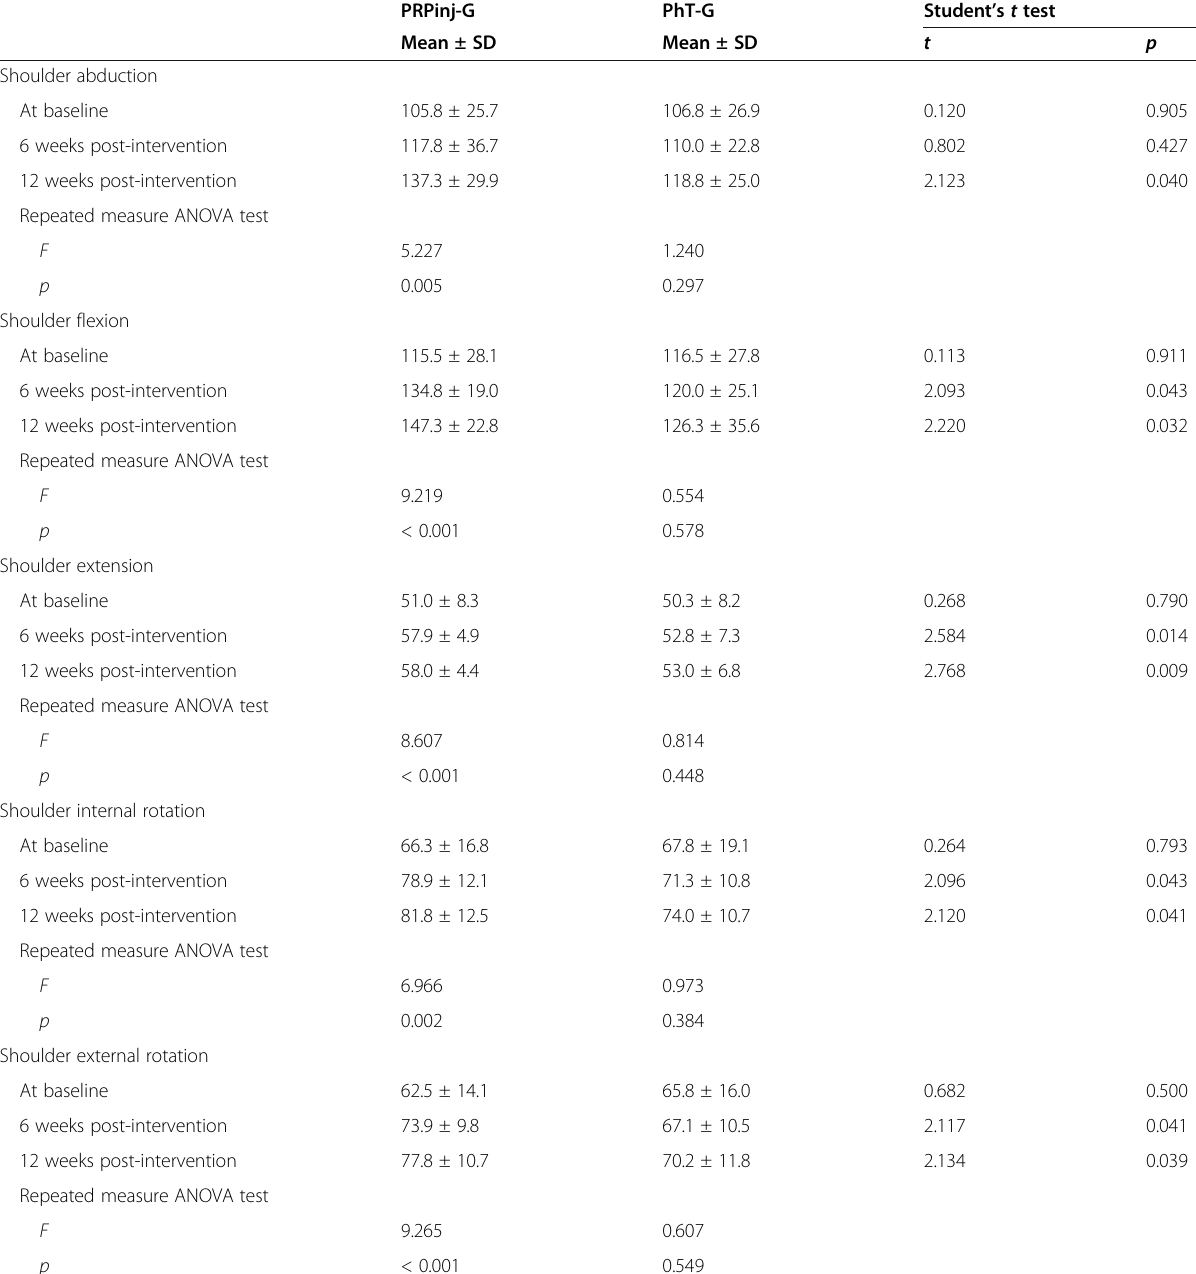
Table 4 Comparison of the range of movement of shoulder between the PRPinj-G and PhT-G at baseline and after 6 and 12 weeks post-intervention PRPinj-G PhT-G Student ’ s t test Mean ± SD Mean ± SD